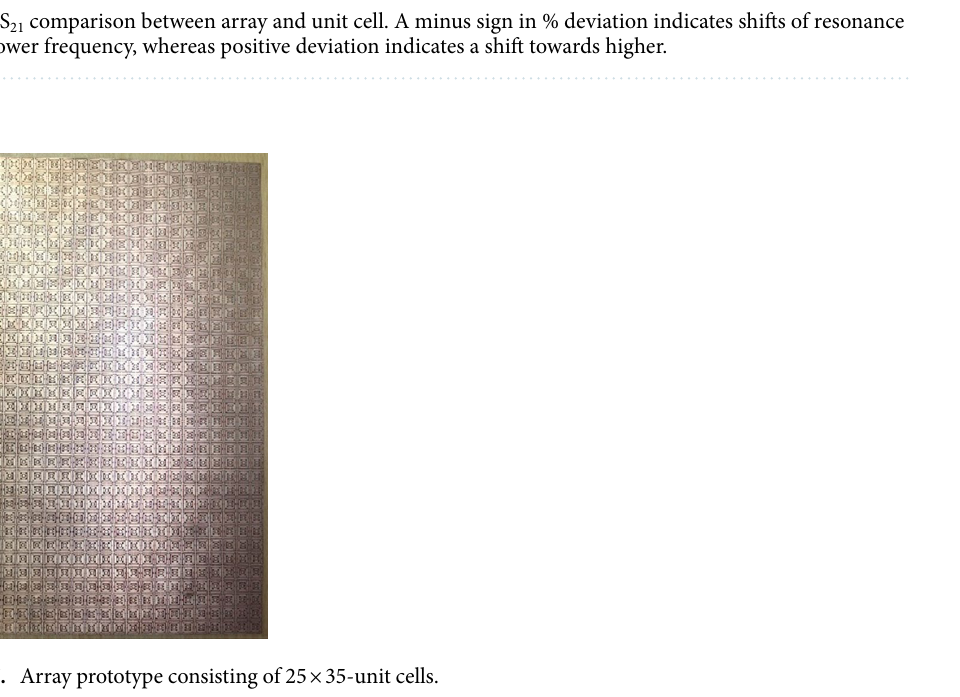
Figure 27. Array prototype consisting of 25 × 35-unit